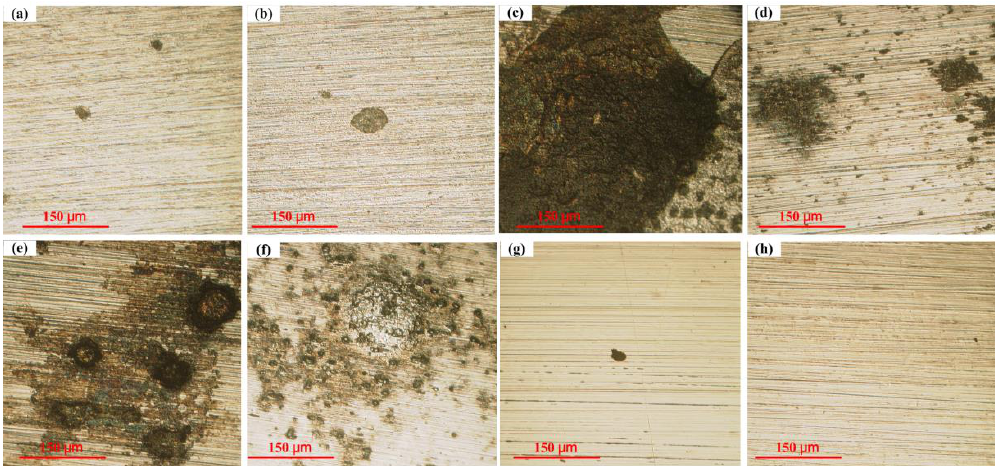
Figure 6. Surface morphologies of the electrodes taken 50 h after the inhibitor was added, ( a ) the surface of WE 1 ( b ) WE 2 ( c ) WE 3 ( d ) WE 4 ( e ) WE 5 ( f ) WE 6 ( g ) WE 7 and ( h ) WE 8.